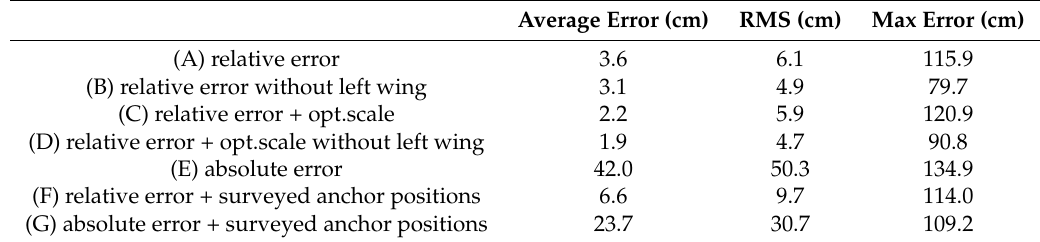
Table 4. Photogrammetric 3D model accuracy assessment: comparison with the TLS 3D